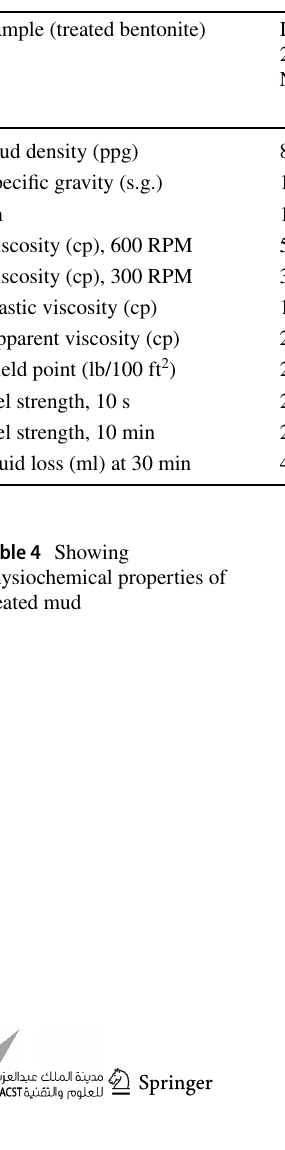
Table 3 Showing physiochemical properties of treated mud